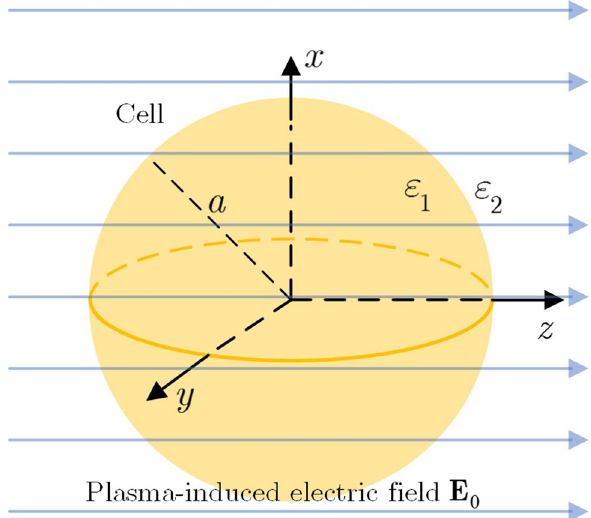
Figure 13. Plasma-induced electric field, E 0 , applied to a spherical cell with no organelles, the radius of cell is a